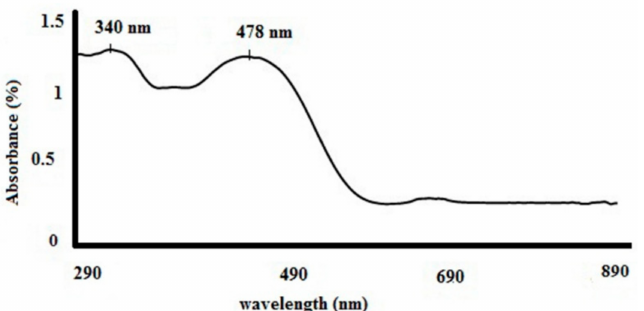
Figure 2. The UV–visible absorption spectrum results of POM in the wavelength range 190–900 nm.